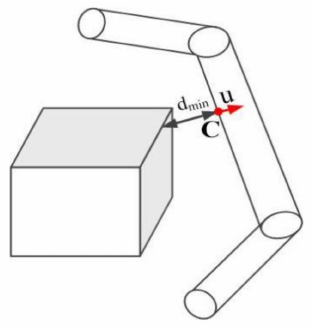
Figure 5. Minimum distance between virtual cylinders and